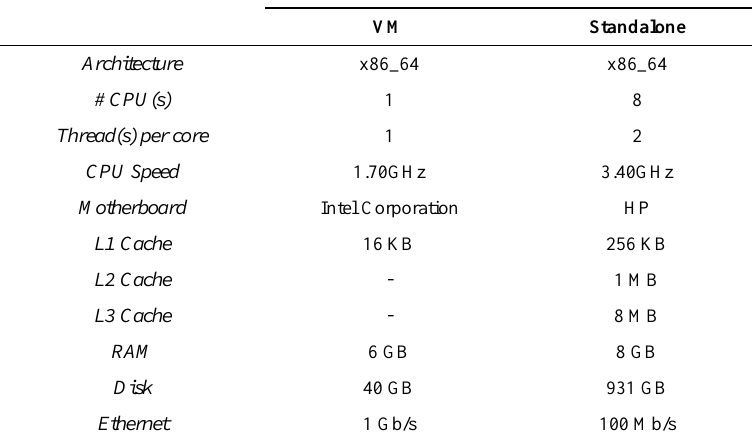
Table 2. Hardware